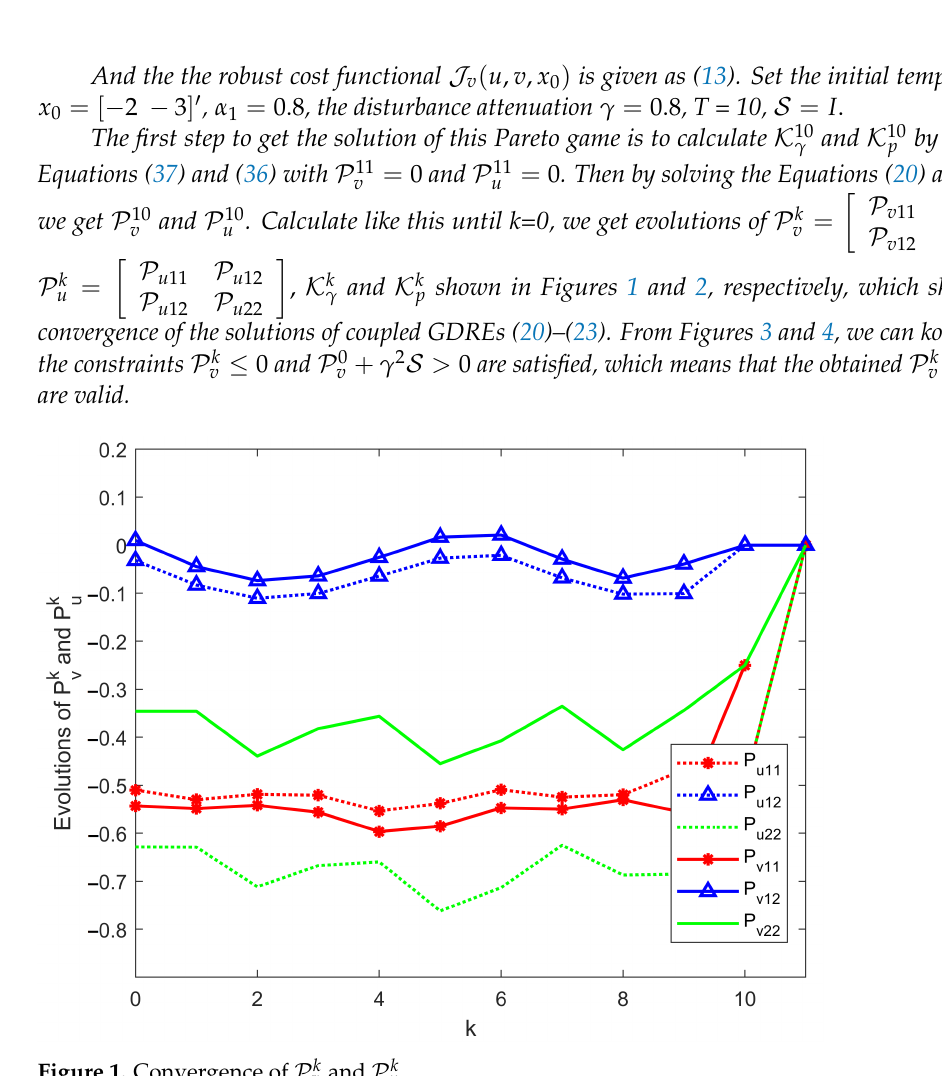
Figure 1. Convergence of P k v and P k u .